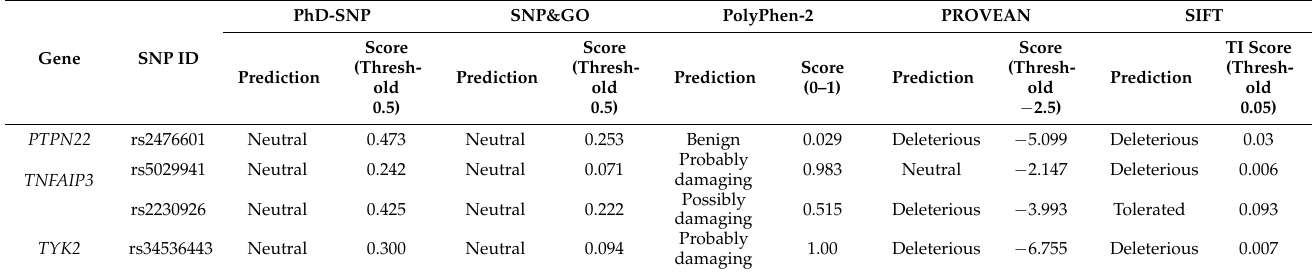
Table 2. SIFT, PROVEAN, PolyPhen2, SNP&GO, and PhD-SNP results for the selected nsSNPs.